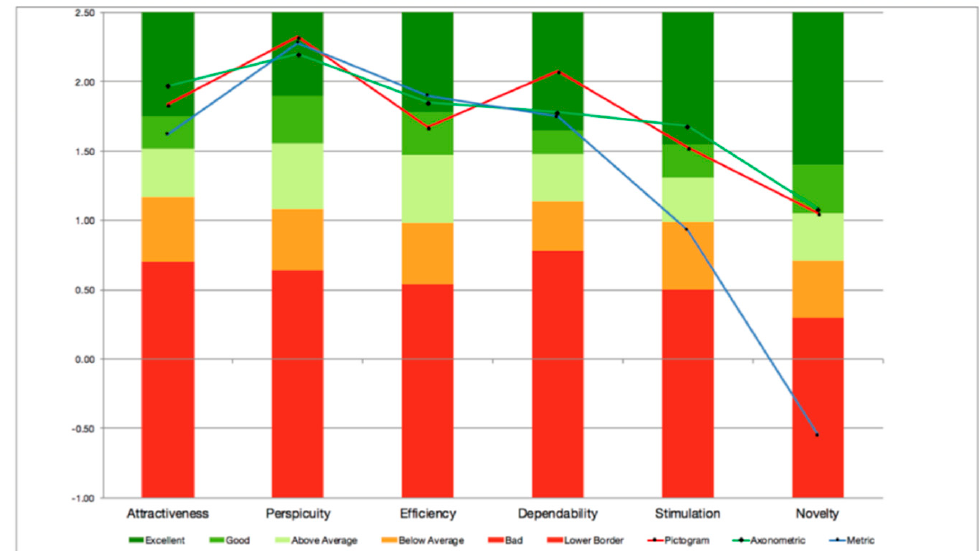
Figure 21. User experience results for every condition, in terms of attractiveness, pragmatic, and hedonic quality aspects.